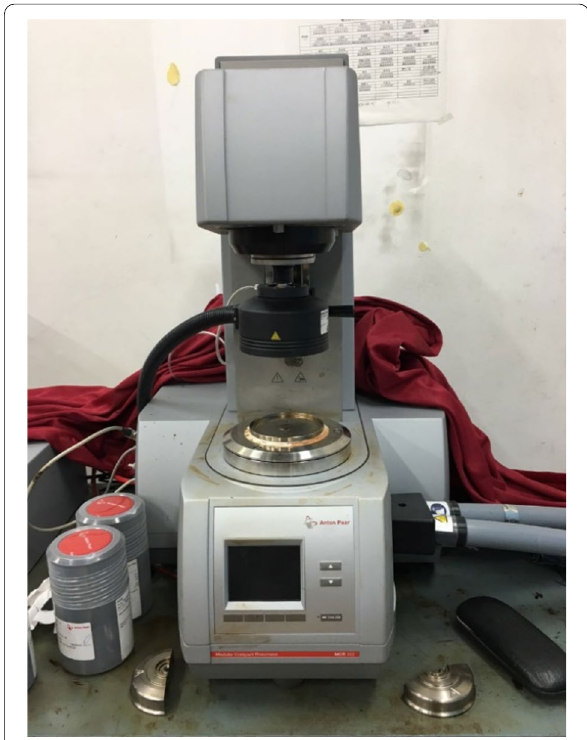
Figure 3 MCR 302